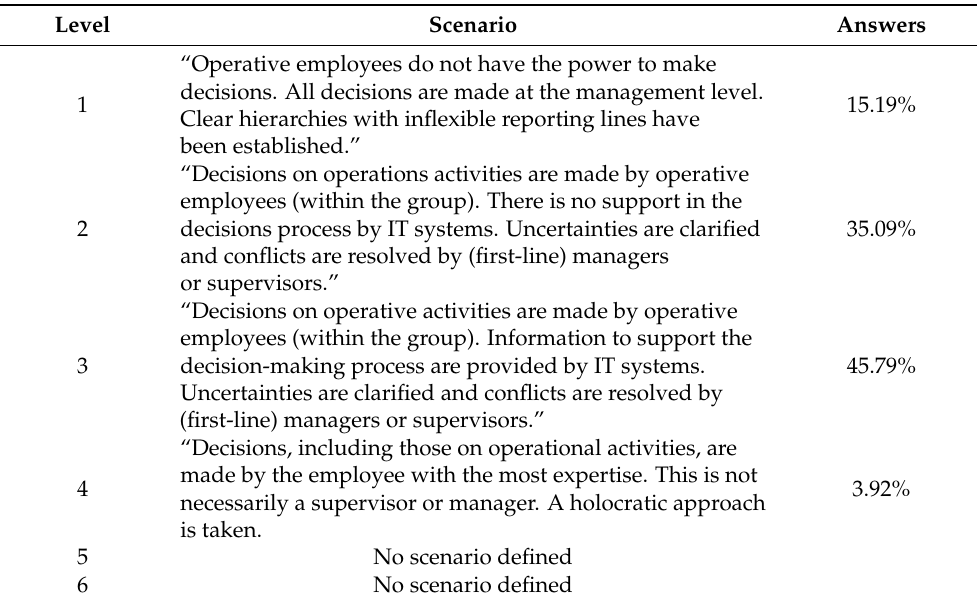
Table 6. Results for the capability “Decision power and